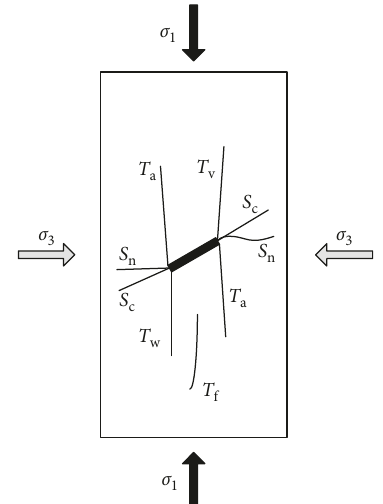
Figure 4: Sketch of the initiated crack types in the cylindrical specimens with a grout-infilled flaw under triaxial compression (modified after Yang and Huang [9] and Lajtai